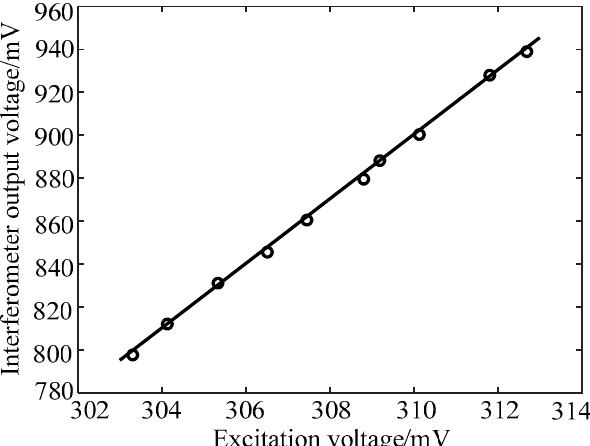
Figure 7. The relationship between the output voltage of the F–P interferometer and the excitation signal voltage.